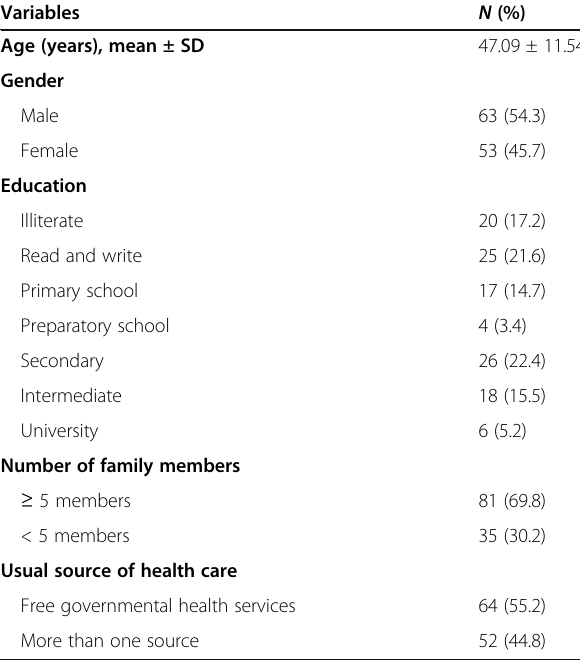
Table 1 Baseline socioeconomic characteristics of the